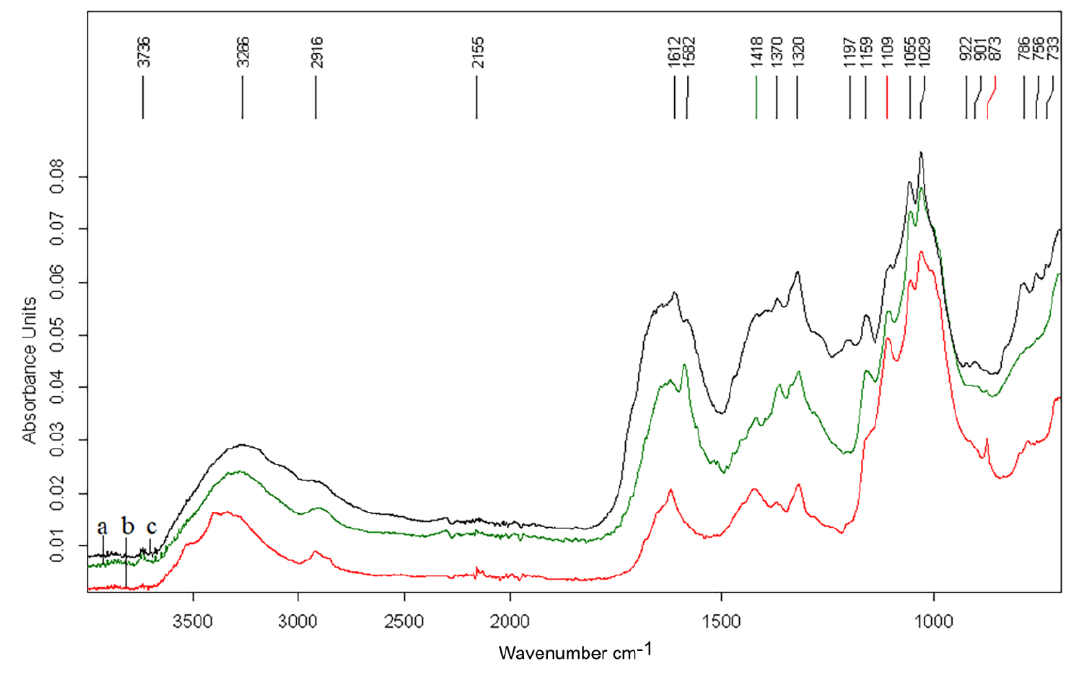
Figure 8. Ink on the three paper media: ( a ) S1, ( b ) S2, ( c ) S3.